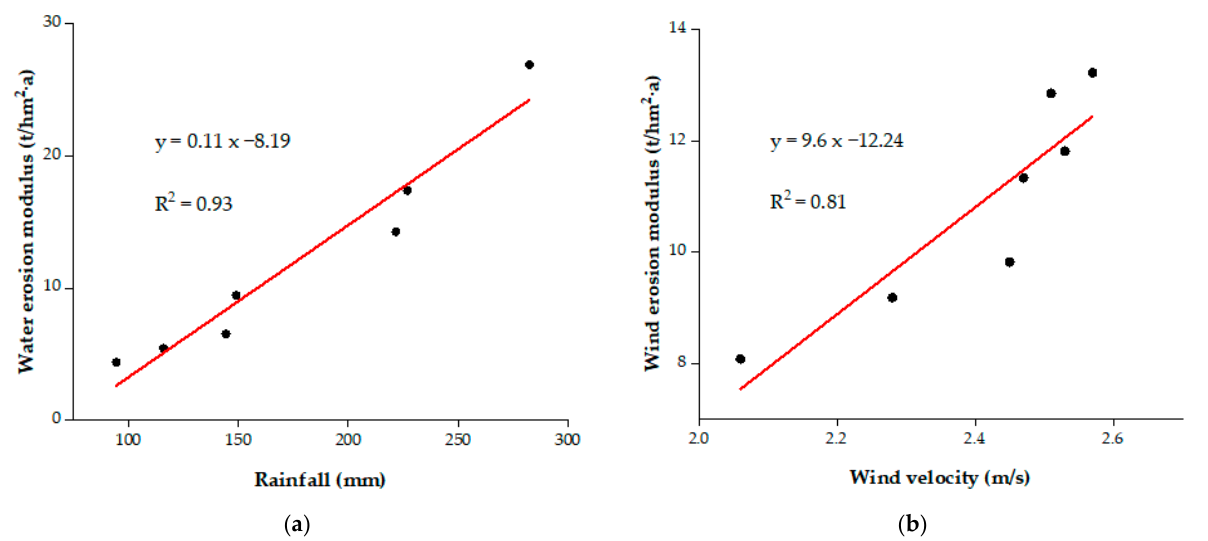
Figure 7. Relationship between soil erosion and meteorological factors in Baotou City. ( a ) Relationship between water erosion modulus and precipitation; ( b ) relationship between wind erosion modulus and wind velocity.